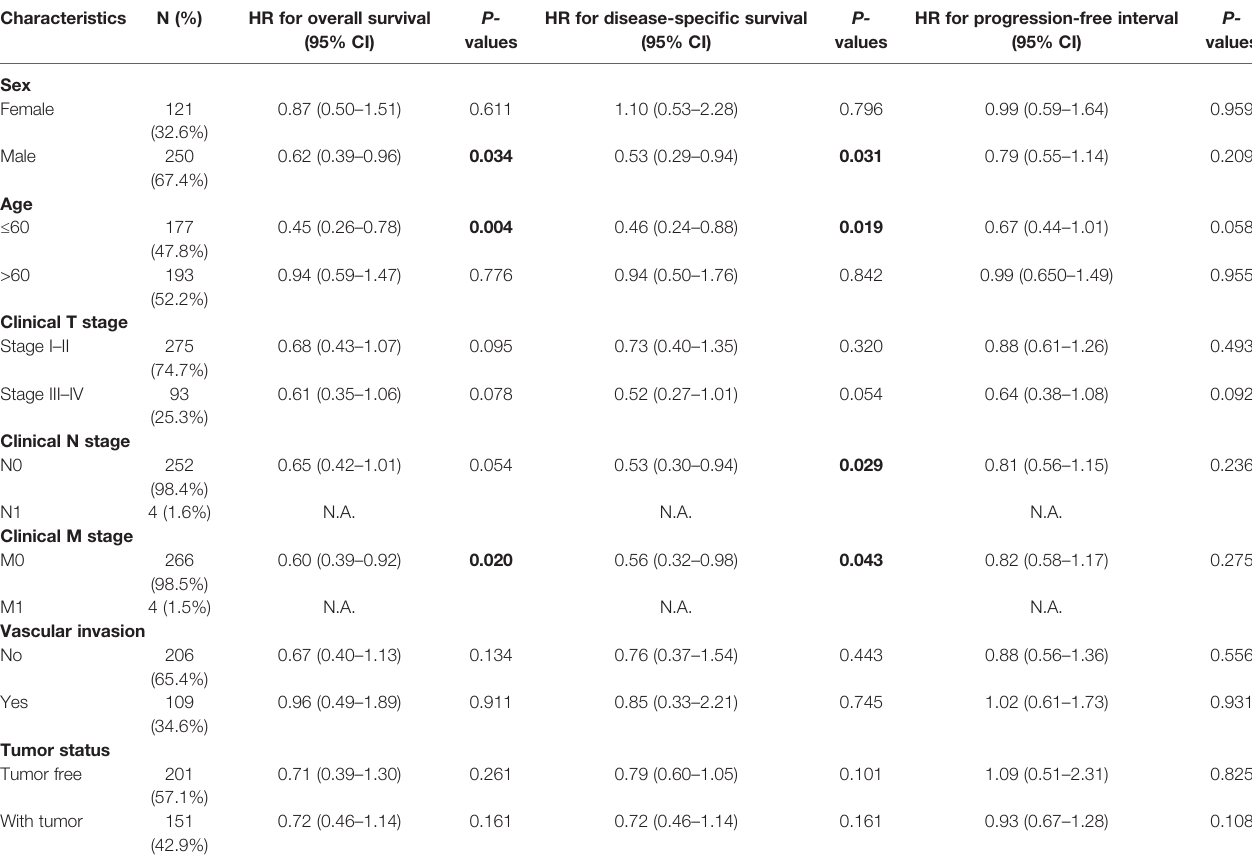
TABLE 4 | Prognostic performance of NDRG2 on clinical prognosis in various liver cancer patient subgroups by Cox regression analysis.